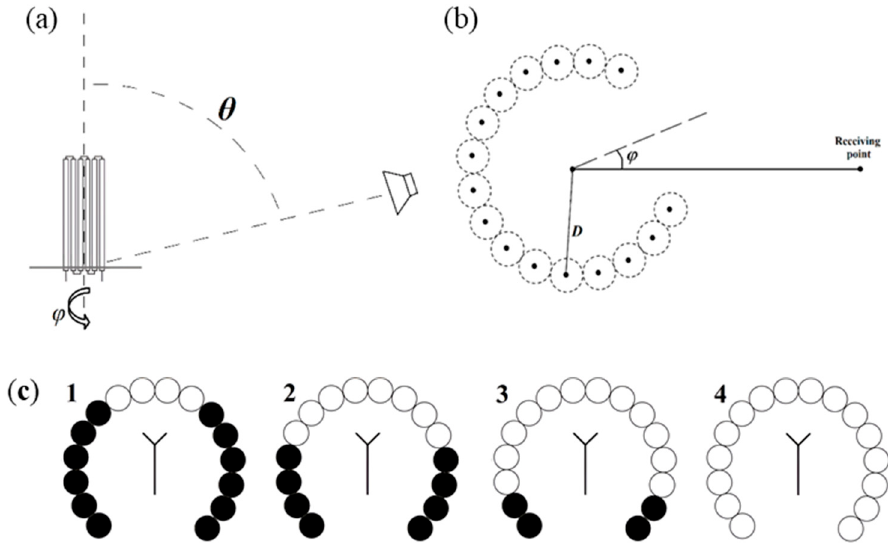
Figure 3. ( a ) Geometry of the location of the antenna system under study and ( b ) the schematic diagram of experimental measurements ( top ); ( c ) various combinations (1–4) of turned-on (indicated by white) and turned-off (indicated by black) lamp groups ( below